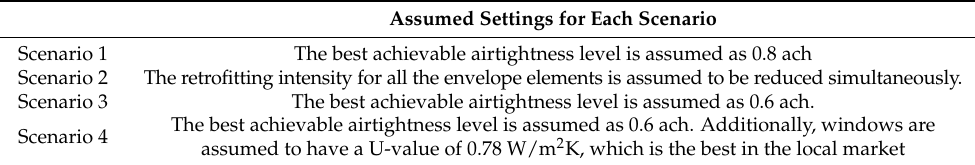
Table 3. The four considered scenarios for envelope performance